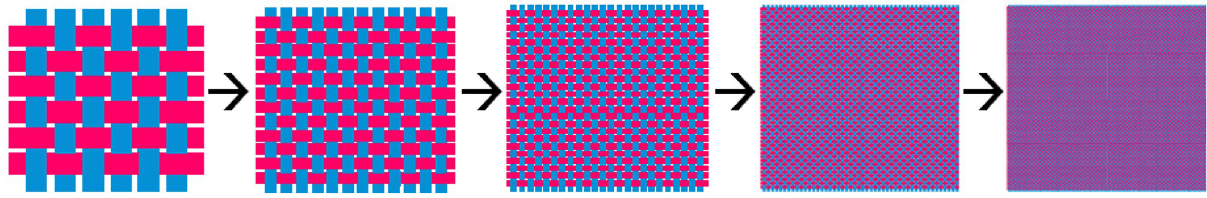
Figure 1. Optical color mixing in a woven